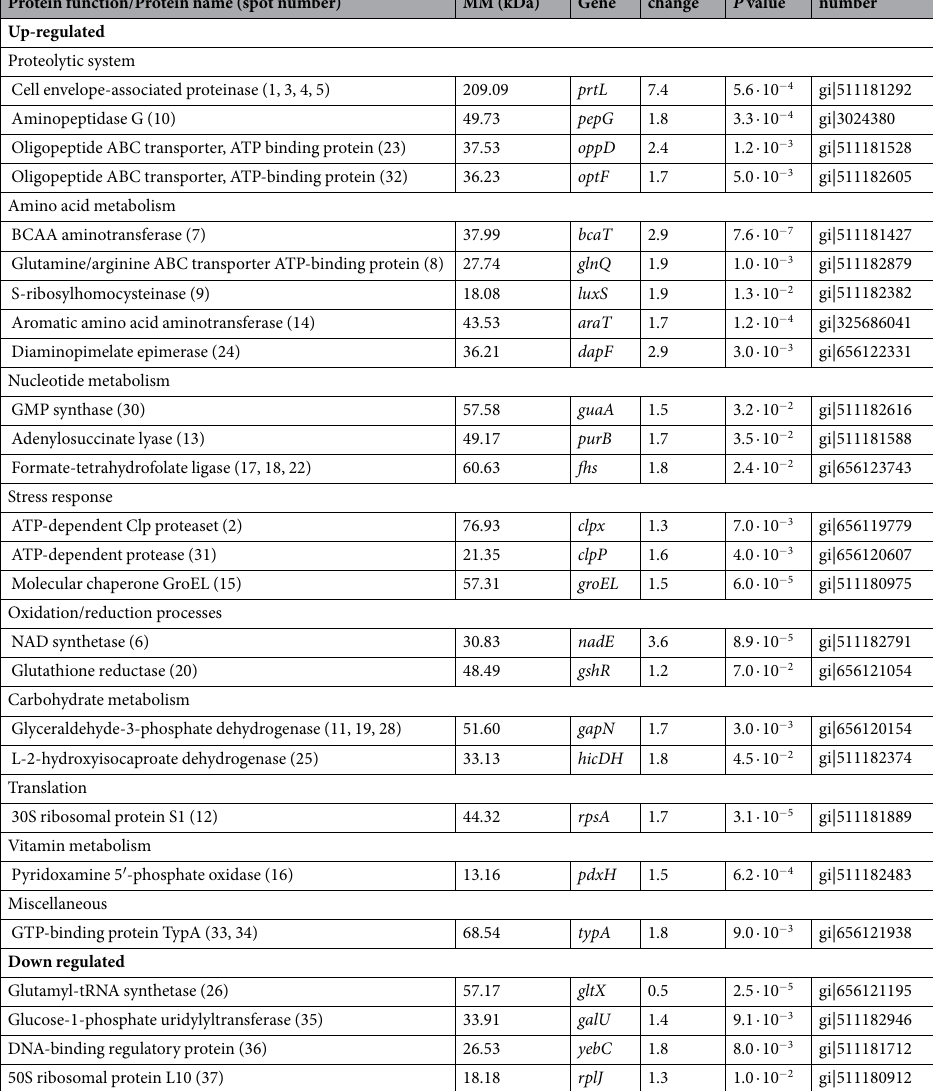
Table 3. Proteome modification of L . delbrueckii subsp. lactis CRL 581 during growth in CDM compared to CDM supplemented with